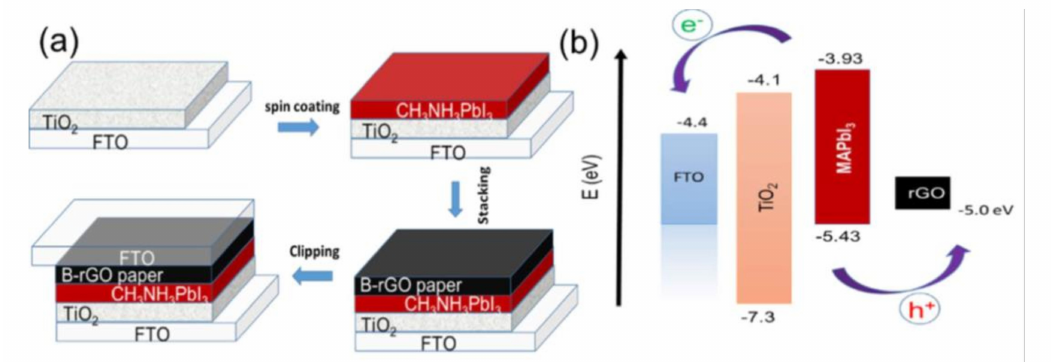
Figure 7. ( a ) Schematic illustration of the fabrication of boron-doped rGO paper as an HTL in perovskite solar cells. ( b ) Energy level diagram of the devices. Reprinted from D. Selvakumar et al., (2018), [28] Copyright (2018), with permission from